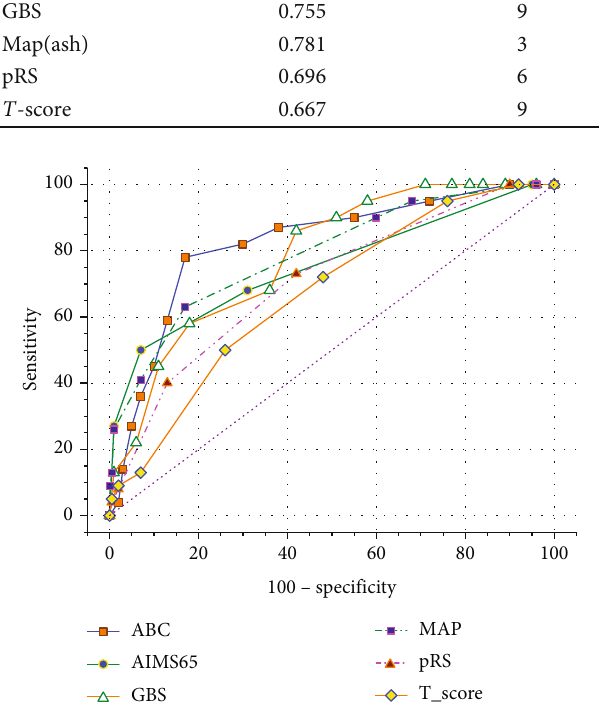
Figure 1: ROC curves for six scoring systems in evaluation of